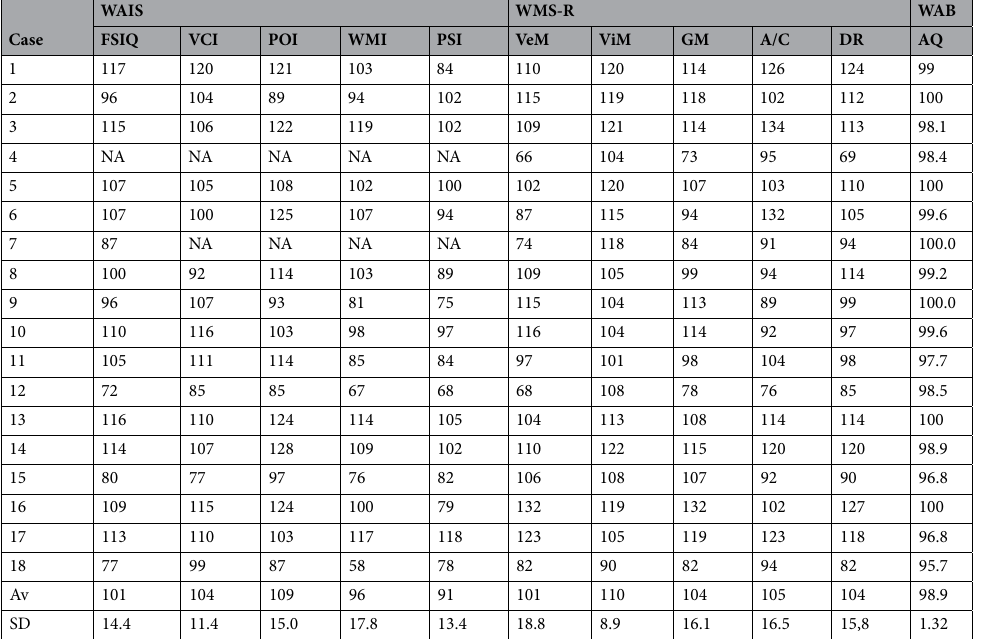
Table 2. Results of evaluations of neurocognitive functions by patient. WAIS scores: FSIQ full-scale intelligence quotient, VCI verbal comprehension index, POI perceptual organization index, WMI